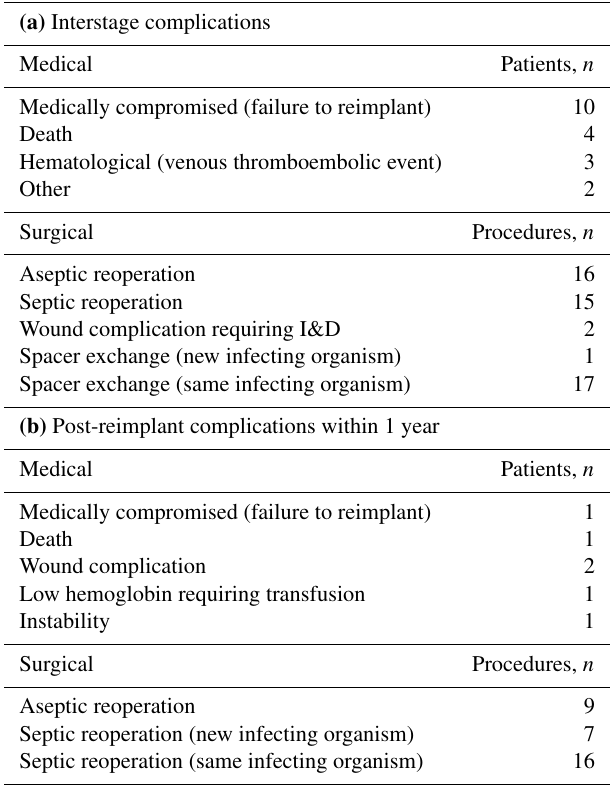
Table 3. Interstage and post-reimplant